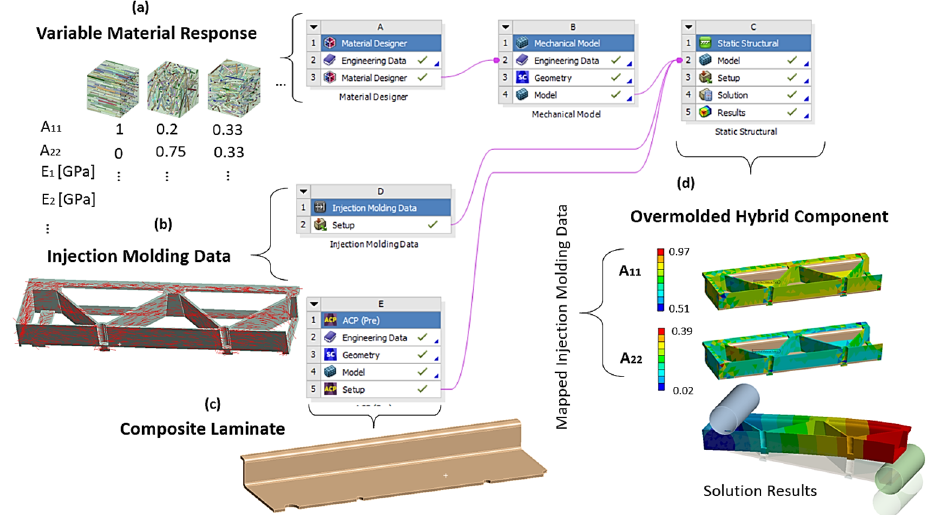
Figure 7. Workflow of the multiscale model in ANSYS Mechanical using the Material Designer (MD): ( a ) creation of the material response as a function of the microstructure by an interpolation grid with attached elastic and plastic parameters, ( b ) import of injection molding data, i.e., the second order orientations tensors from the injection molding software, ( c ) modeling of the ply-based continuous fiber-reinforced TPC laminate and ( d ) mapping of the injection molding data to the short fiber-reinforced parts and bonding to the continuous fiber-reinforced laminate.